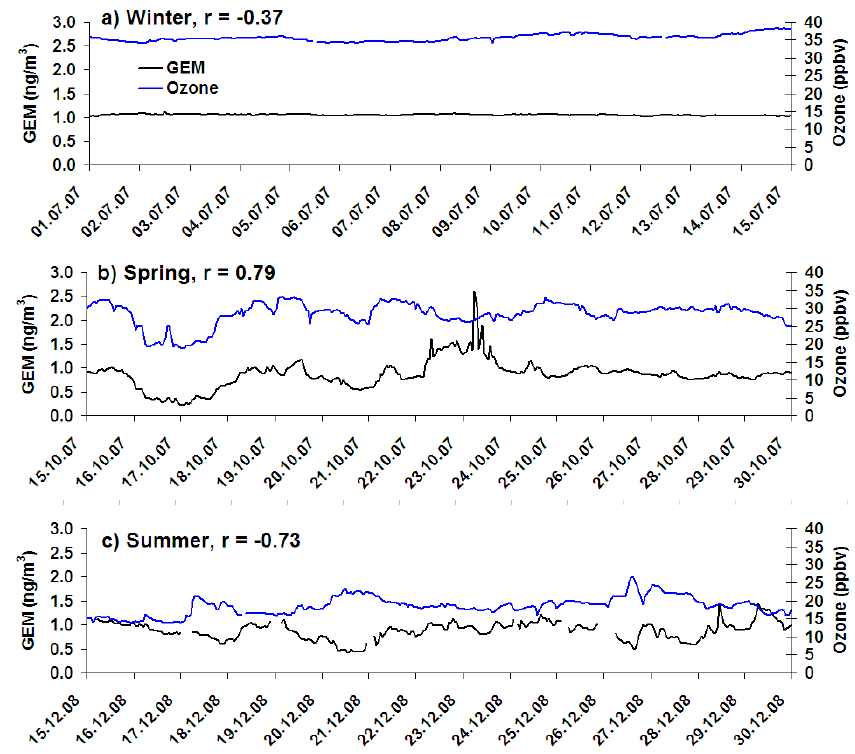
Figure 3. Time series of GEM and Ozone concentrations from TRS representing the seasons (a) winter, (b) spring and (c) summer. The correlation coefficient, r, for GEM and Ozone is also indicated.